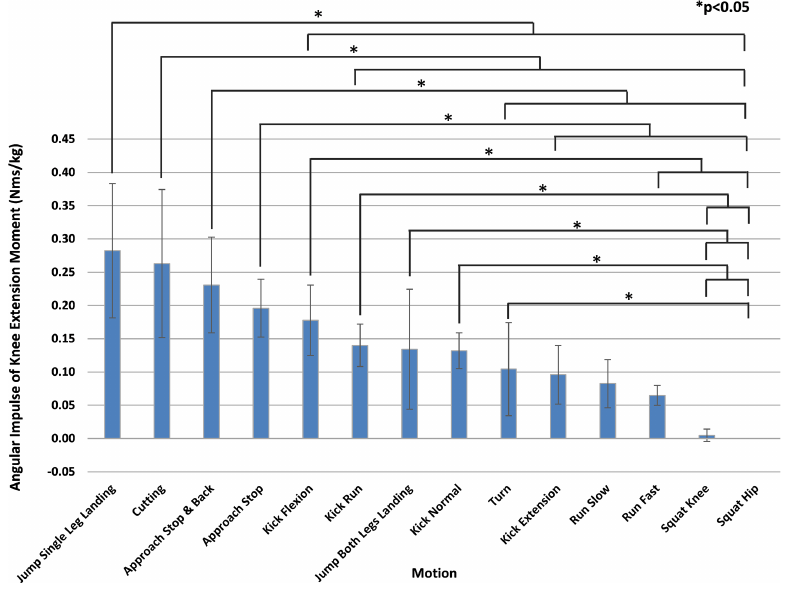
Fig 2. Motion comparison by averageangular impulse of the knee extension moment (1.0 Nm/kg or greater). Mean values are shown in descendingorder from left to right. "Jump SingleLeg Landing"was significantly greater than "Kick Flexion"with other motions rankedbelow that. Multiple comparisons were performed after ANOVA to show statistically significantdifferencesbetweenmotions. * P < 0.05.